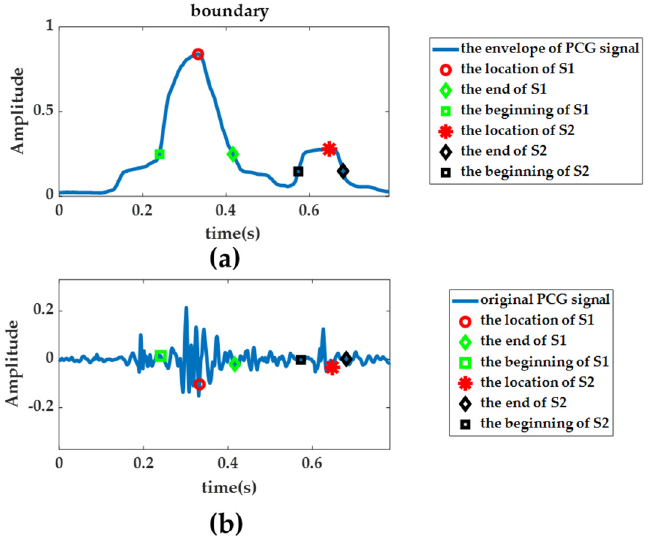
Figure 6. The boundary of a heart sound. ( a ) Notes of S1, S2 and the boundaries of S1 and S2 on the envelope. ( b ) Notes of S1, S2 and the boundaries of S1 and S2 on the original heart sound signal.